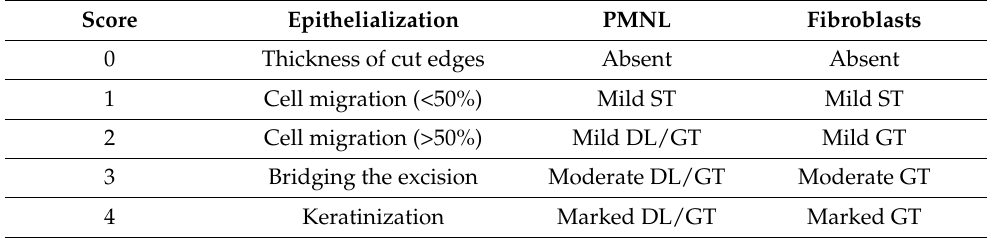
Table 7. Semi-quantitative histological scoring of wound healing